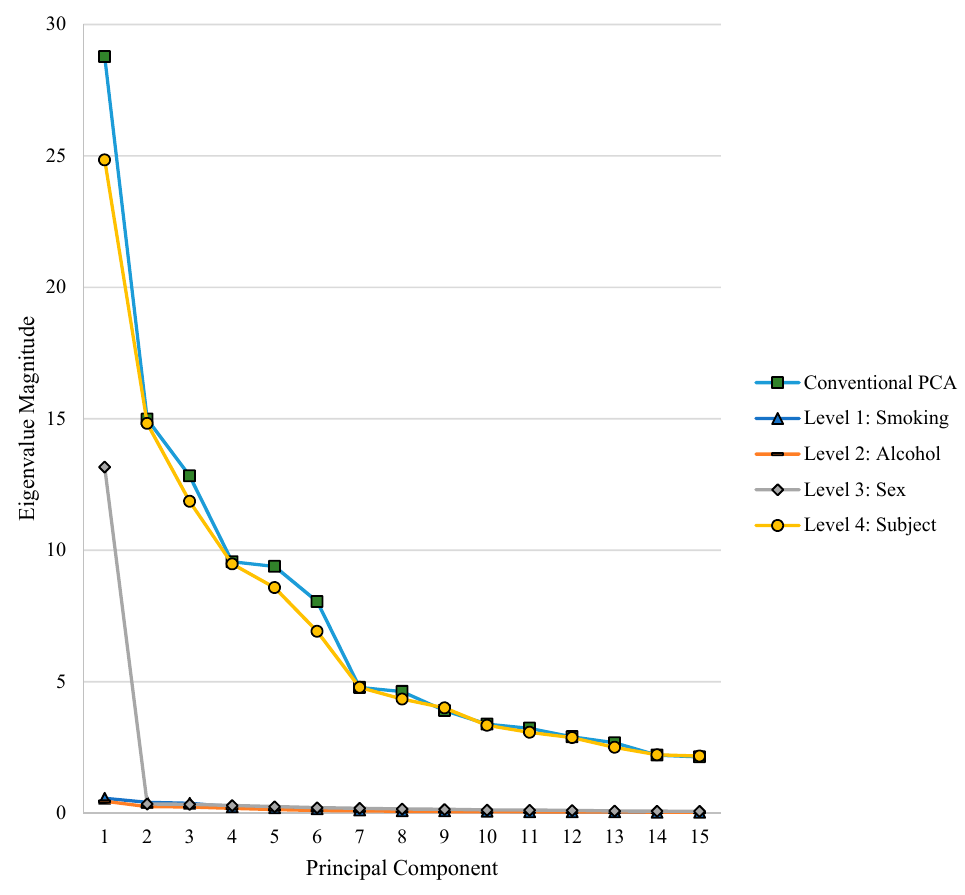
Figure 3. Eigenvalue plot allowing visualisation of the eigenvalue magnitude for each principal component, at each level of the model. Table 2. Percentage of the total variation in the 21 facial landmarks as explained by each level.